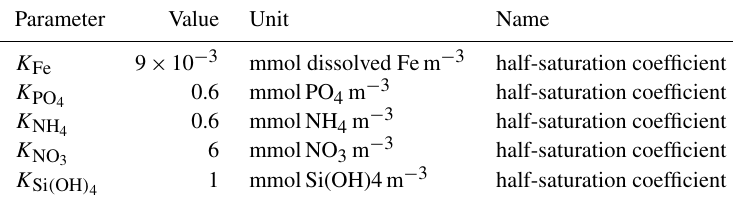
Table A3. Parameter values used in TOPAZv2 to compute the production and grazing of large phytoplankton. Parameter Value Unit Name